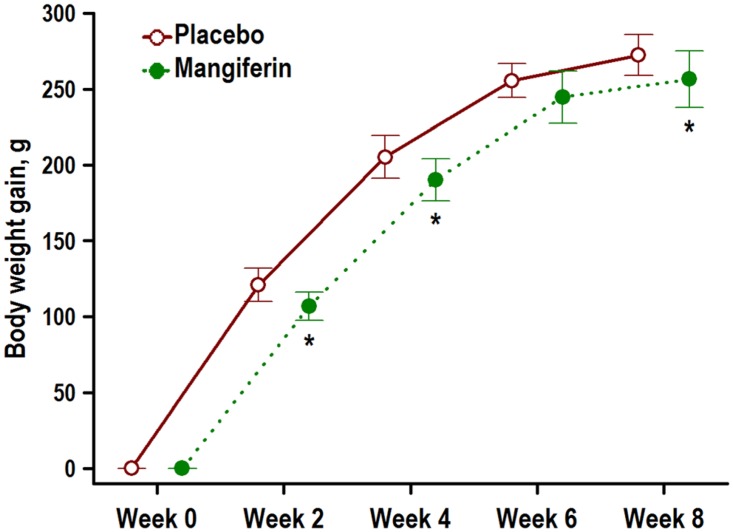
Mangiferin mitigates overweight in obese rats.Zucker rats with the obese (fa/fa) phenotype (2 months old) were treated with placebo or with mangiferin (15 mg/kg BW/days) for 8 weeks, and body weight was monitored every two weeks. Graph shows means ± SD body weight gain over time, n = 10 rats/group. * P < 0.05 indicates significant differences between Placebo and Mangiferin groups obtained by unpaired Student’s t test.